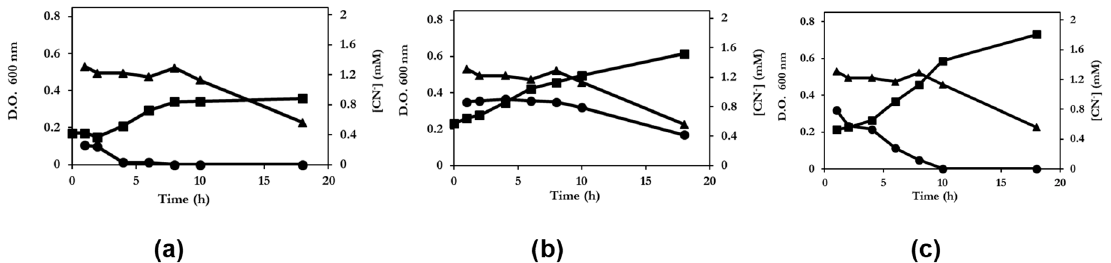
Figure 1. Growth of P. pseudoalcaligenes CECT 5344 R1 ( a ), M. kitamiense ( b ) in pure cultures and growth of P. pseudoalcaligenes CECT 5344 and M. kitamiense in co-cultures ( c ) with cyanide residue (2 mM free cyanide as final concentration) from the jewellery industry as the sole nitrogen source. Cells were inoculated in media at pH 9.5 containing DL-malate (4 g/L) as the carbon source. At the indicated times, the increments of cell growth of the culture growing with cyanide with respect to the control culture ( ) and the cyanide concentration in the culture supernatant ( ) were measured. The concentration of cyanide in a noninoculated flask containing culture medium ( ) was measured at the same